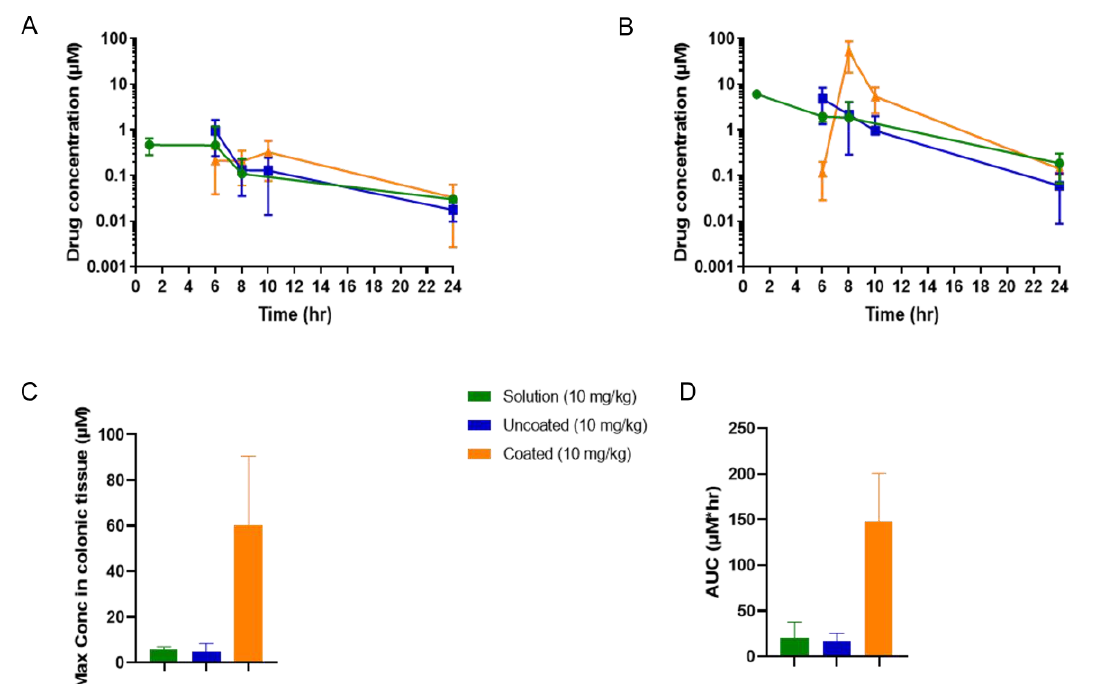
Figure 4. Concentrations of tofacitinib in rats’ colonic tissue following administration of a solution, uncoated capsules, and coated capsules dosed at either 1 mg/kg ( A ) or 10 mg/kg ( B ) tofacitinib. ( C ): The maximal tofacitinib concentrations of the 10 mg/kg solution, uncoated capsules, and coated capsules measured in colonic tissue. ( D ): Area under the curves (AUCs) of the 10 mg/kg tofacitinib formulations’ colonic tissue concentration–time results (from data shown in ( B ), measurement starting at 6 h post-dose). AUC solution vs. coated p ≤ 0.0350 and uncoated vs. coated p ≤ 0.0312. Maximal concentration solution vs. coated p ≤ 0.0210 and uncoated vs. coated p ≤ 0.019.